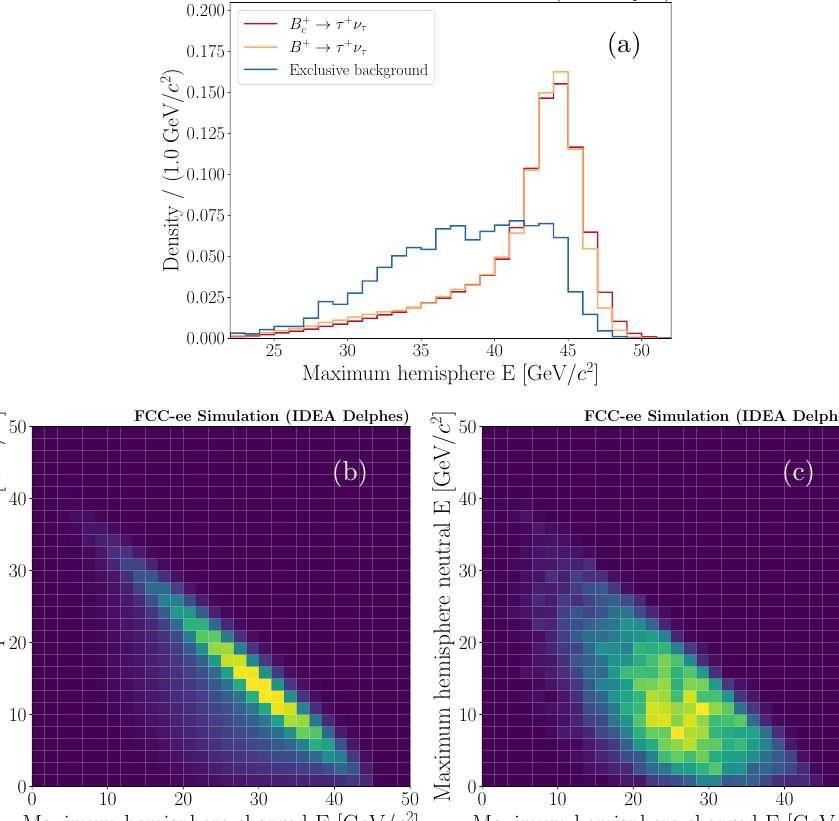
Figure 5 . (a) Distribution of total hemisphere energy for the maximum energy hemisphere. Signal and B + → τ + ν decays closely follow the expected distribution for an inclusive b -quark decay from τ a Z , whereas the background distribution is biased downwards by the selection. (b/c) Relationship between the total charged and neutral energy in the maximum energy hemisphere for B + inclusive Z → b ¯ b